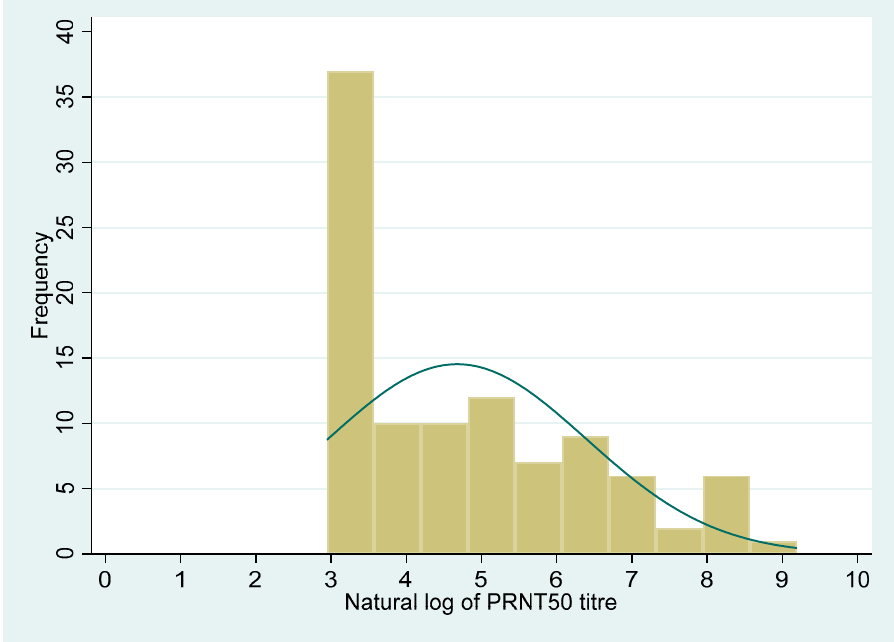
Figure 3. Distribution of neutralizing antibody titres (PRNT 50 ) among the participants (the scale is a natural logarithm for PRNT 50 titre).